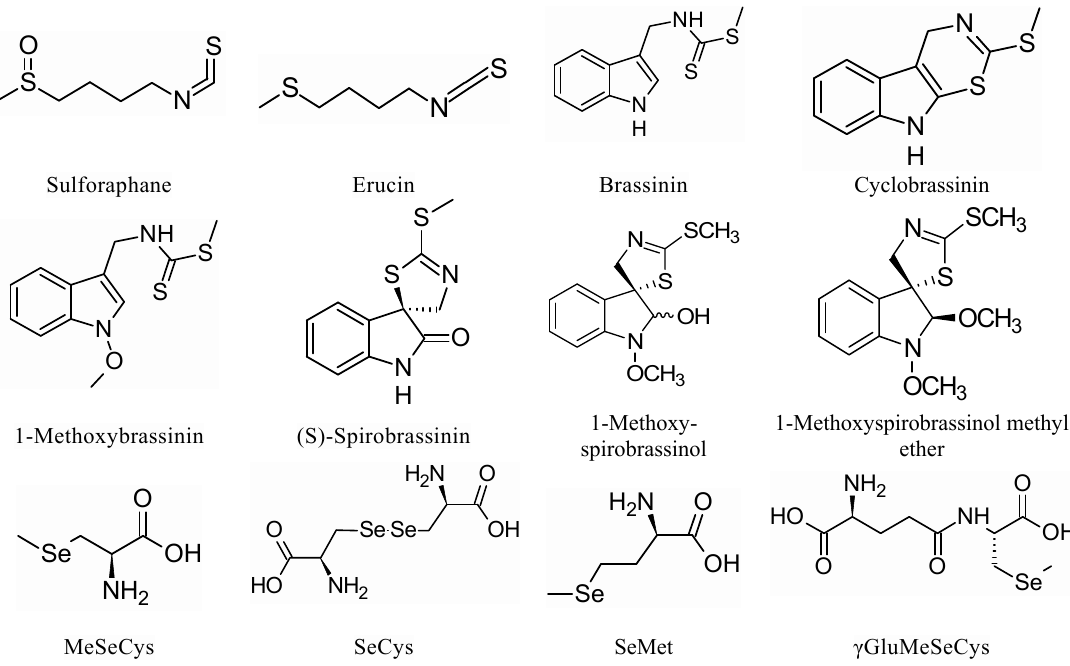
Figure 1. Some naturally occurring organosulfur and organoselenium compounds obtained from Brassicaceae with chemopreventive effects.